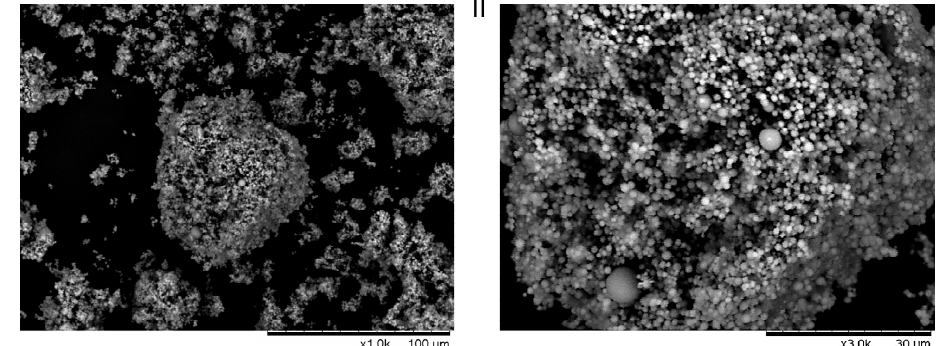
Figure 2. SEM images of the sol–gel Hoveyda–Grubbs second-generation catalyst-CAL-B conjugate. ( I ) Lower magnification; ( II ) Higher magnification.